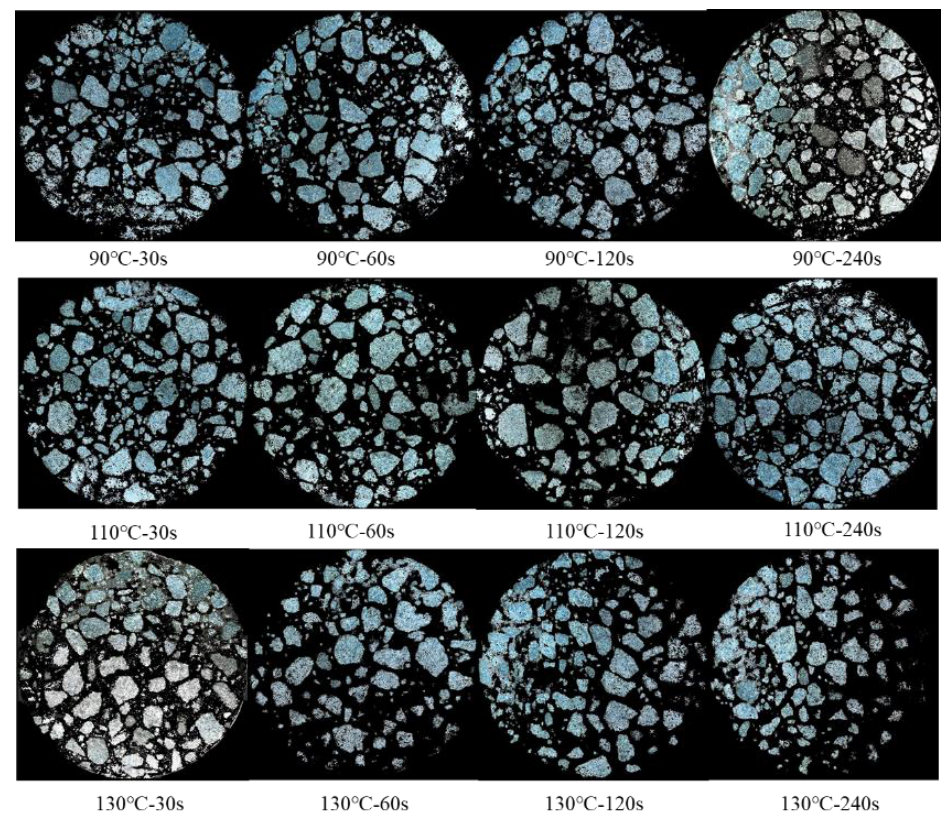
Figure 11. Visualization of aggregate distribution at different mixing conditions